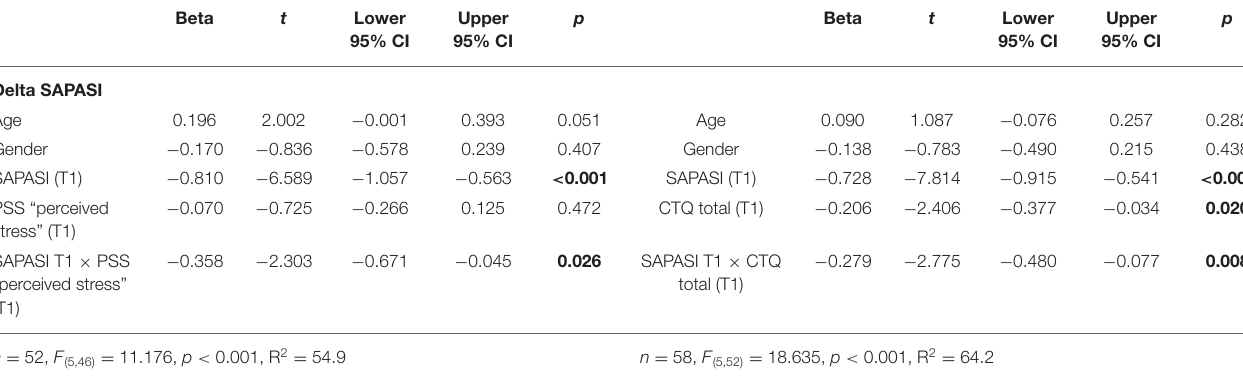
TABLE 5 | Results of the moderator analysis according to the Macro Modell Process by